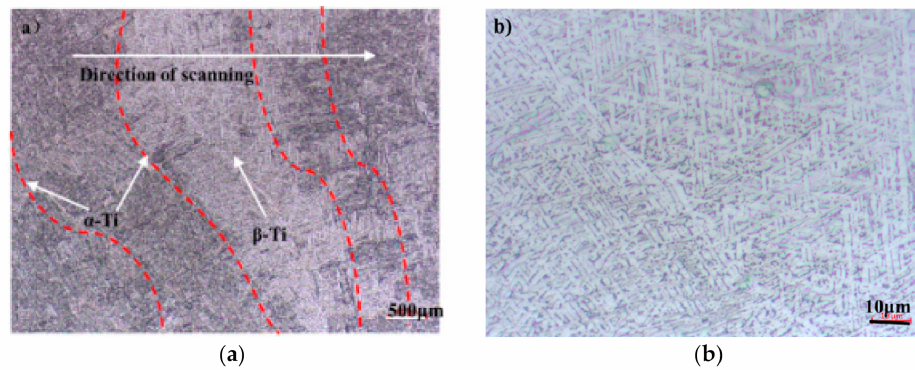
Figure 3. Macroscopic appearance of the as-deposited layer. ( a ) Bottom area, ( b ) top